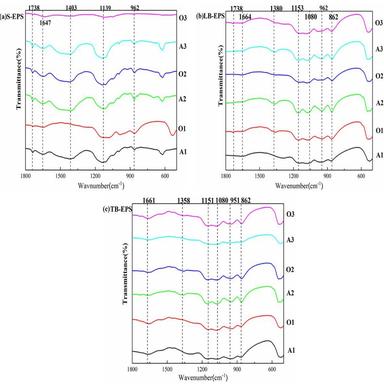
FTIR spectra analysis of (a) S-EPS, (b) LB-EPS and (c) TB-EPS in different zones.